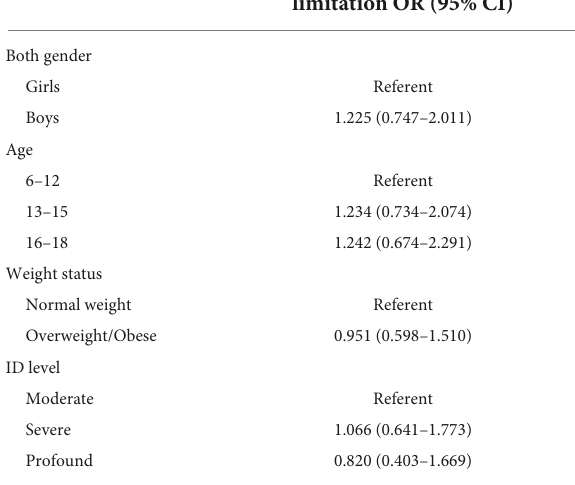
TABLE 2 Prevalence estimates of after-school screen-based SB time limitation among children and adolescents with ID by gender, age, weight status, and ID level.